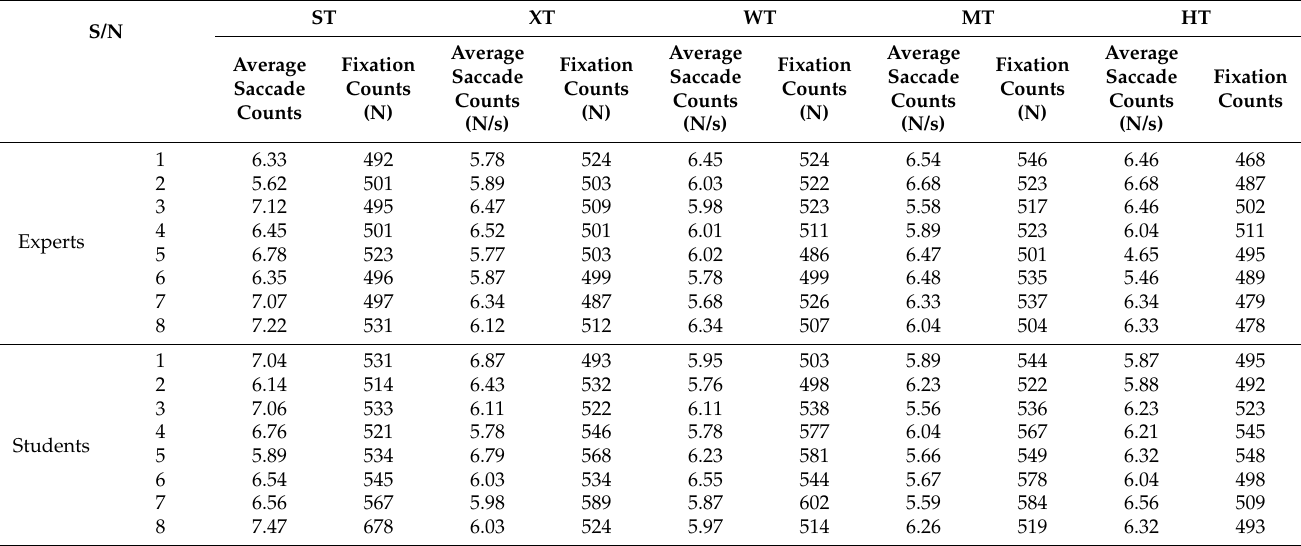
Table 3. Statistics on the fixation counts and average saccade counts of subjects after cultural landscape remediation.